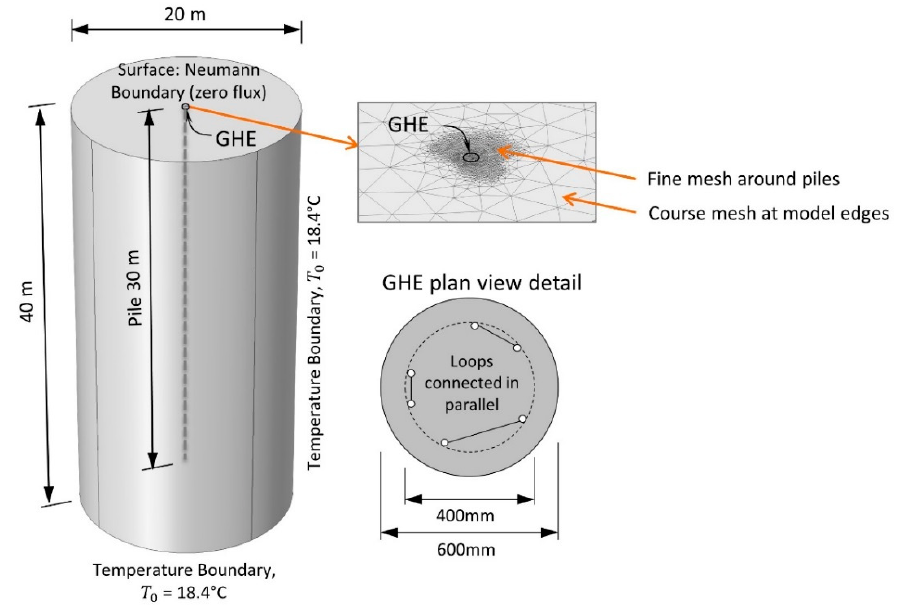
Figure 4. Numerical model geometry, extent and boundary conditions.